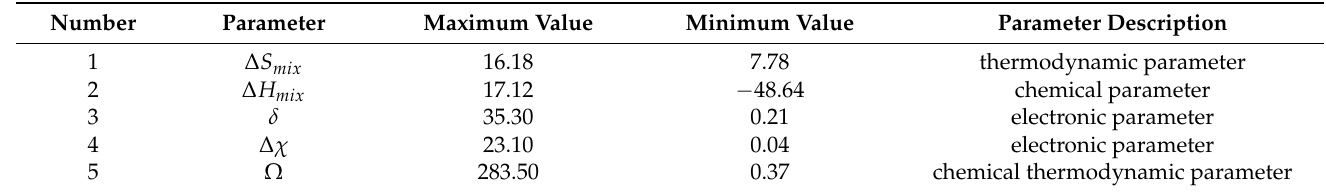
Table 1. Maximum values and minimum values of the five parameters.